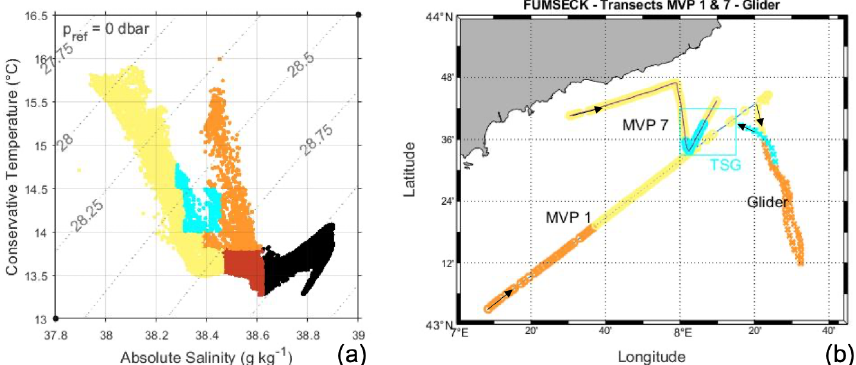
Figure 7. Water mass types measured by the MVP (MVP 1 from 30 April at 21:29 to 1 May at 07:50UTC; MVP 7 from 5 May at 19:22 to 6 May at 05:06UTC) and the glider (descending southward from 1 May at 08:50 to 4 May at 00:29UTC; ascending northward from 4 May at 00:29 to 6 May at 03:42UTC). Panel (a) shows a TS diagram from MVP 7 and ascending glider data. Panel (b) presents a map showing the colour-coded surface waters measured by MVP and the glider as well as the TSG zone of interest. The colours are as follows: recirculation waters are orange, NC waters are yellow, and newly mixed waters are cyan.